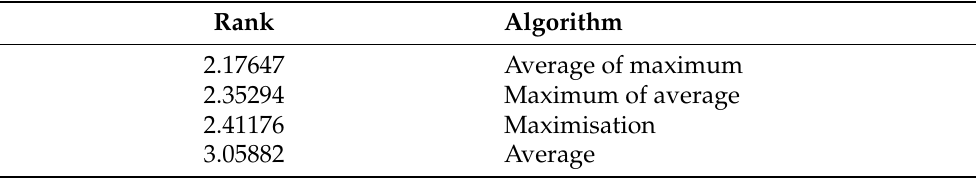
Table 7. Friedman results of the proposed methodology using different aggregation techniques for